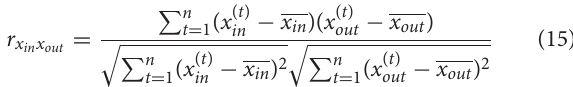
Frontiers in Neuroscience |